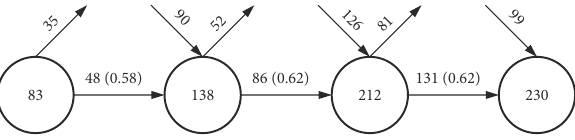
Figure 10. The overlapping map of four sub-periods